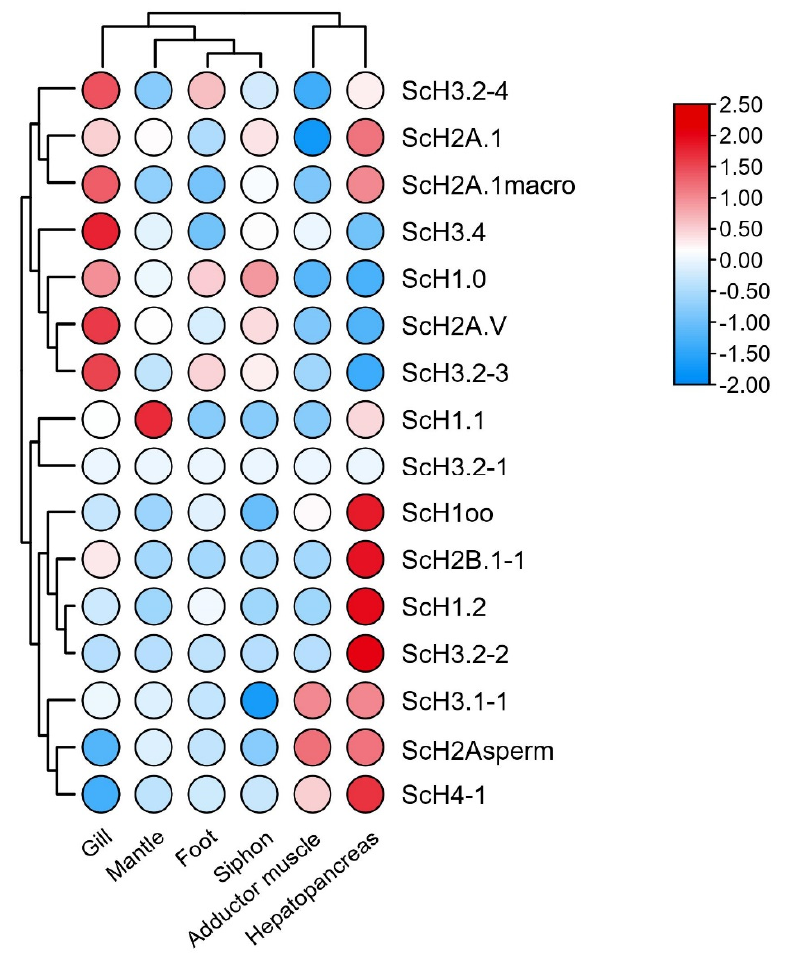
Figure 5. Expression profiles of histone genes in different organs/tissues of adult S. constricta . Log 10 - transformed FPKM (fragments per kilobase of exon model per million mapped fragments) values were used to plot the heatmap. The FPKM values of the histone genes are presented in Table S6.